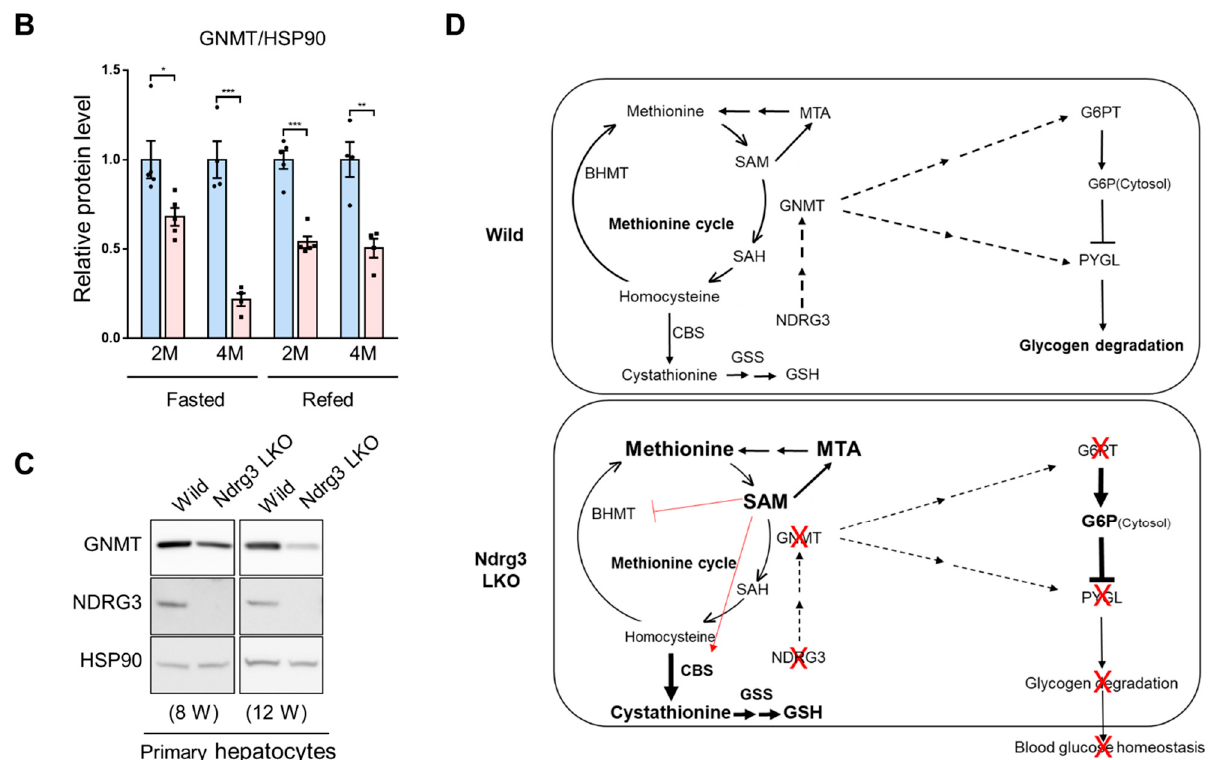
Figure 8. Critical role of GNMT downregulation in the reprogramming of the methionine cycle in Ndrg3 LKO livers. ( A ) qRT-PCR analysis of the expression of genes of the methionine cycle and branch pathways in the livers of wild-type and Ndrg3 LKO mice at 8-10 weeks of age. Mice were fasted for 15 h or refed for additional 6 h before being subject to the gene expression analysis ( n = 4–5 per group). ( B ) GNMT protein expression in the livers of wild-type and Ndrg3 LKO mice. Mice at the age of 2 months ( n = 5 per group) and 4 months ( n = 4 per group) were fasted for 15 h or refed for additional 6 h before being subject to the protein expression analysis. ( C ) Western blot analysis of GNMT expression in primary hepatocytes isolated from wild-type and Ndrg3 LKO mice at 2 or 3 months of age. ( D ) Illustrative scheme describing plausible molecular mechanisms for the induction of methionine cycle reprogramming and GSD phenotypes in Ndrg3 LKO livers. Activation of CBS and inhibition of BHMT by SAM are indicated by red lines. Gene expression was normalized using Gapdh as the reference. Data are presented as mean ± SEM. p -values were calculated using two-tailed Student’s t -test. * p < 0.05, ** p < 0.01, and *** p < 0.001 vs. wild